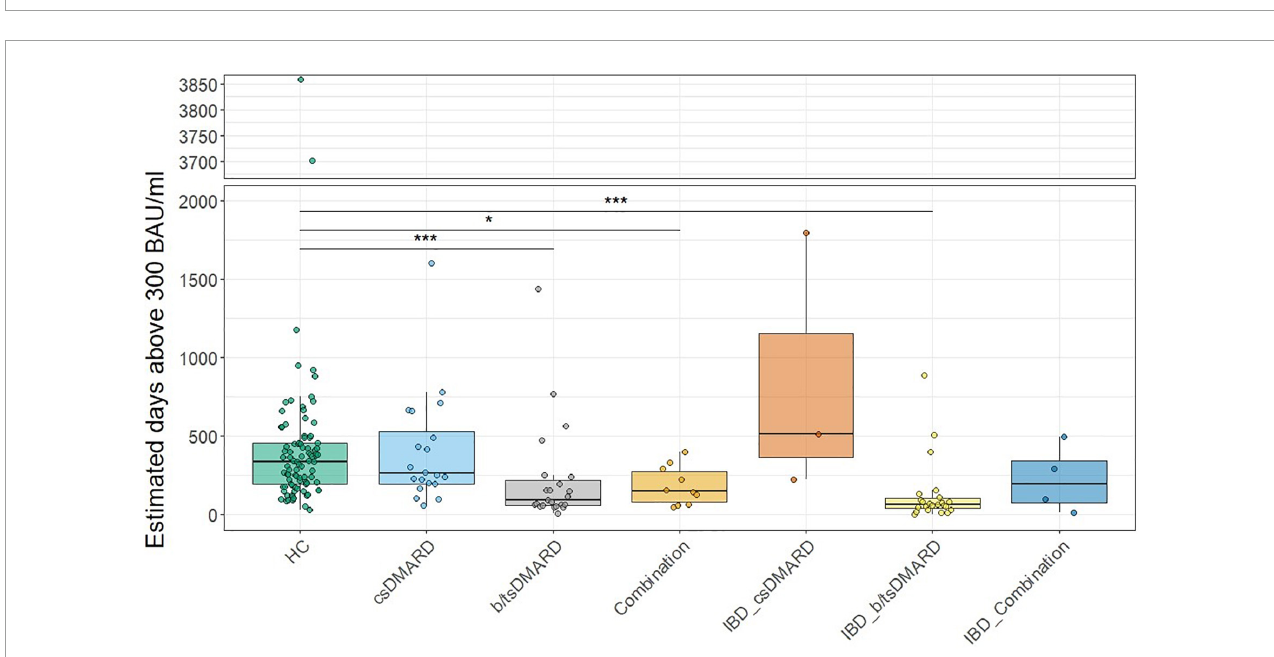
FIGURE3 Estimation of median days above 300 BAU/ml in HC or inflammatory arthritis patients or inflammatory bowel disease (IBD) patients receiving the indicated treatments: csDMARD ( n = 30), b/tsDMARD ( n = 54), and a combination of csDMARD and b/tsDMARD ( n = 28) compared with healthy